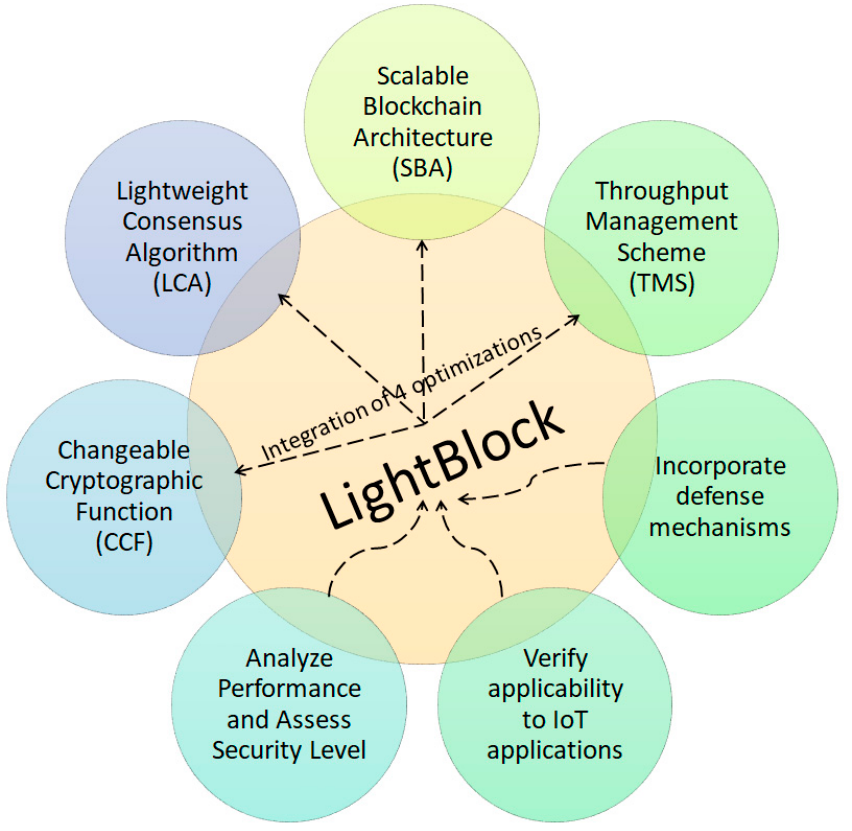
Figure 2. Conceptual model.